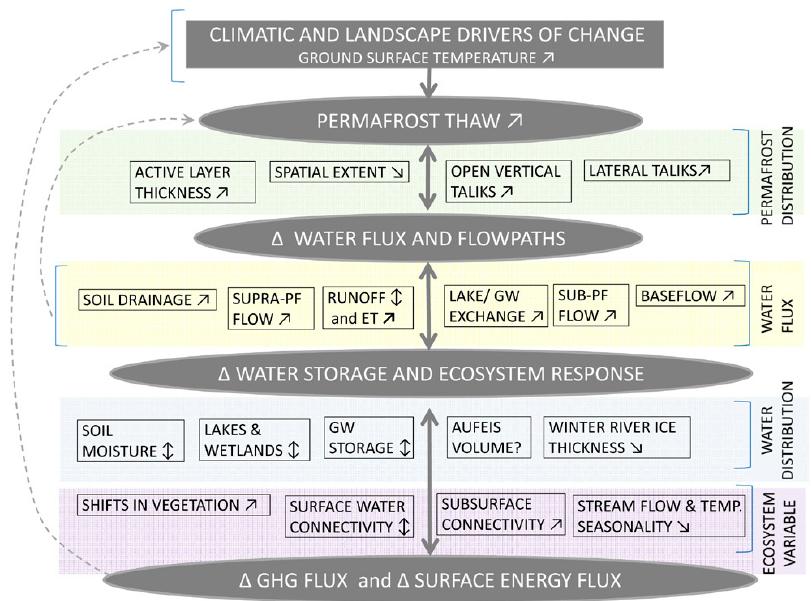
Figure 1. A sketch of impacts and responses of permafrost thawing on water fluxes and distribution. The symbols of △ , ↗ , ↘ , ↕ , and ? denote change, increase, decrease, variation, and unknown changes, respectively. Modified from [25].